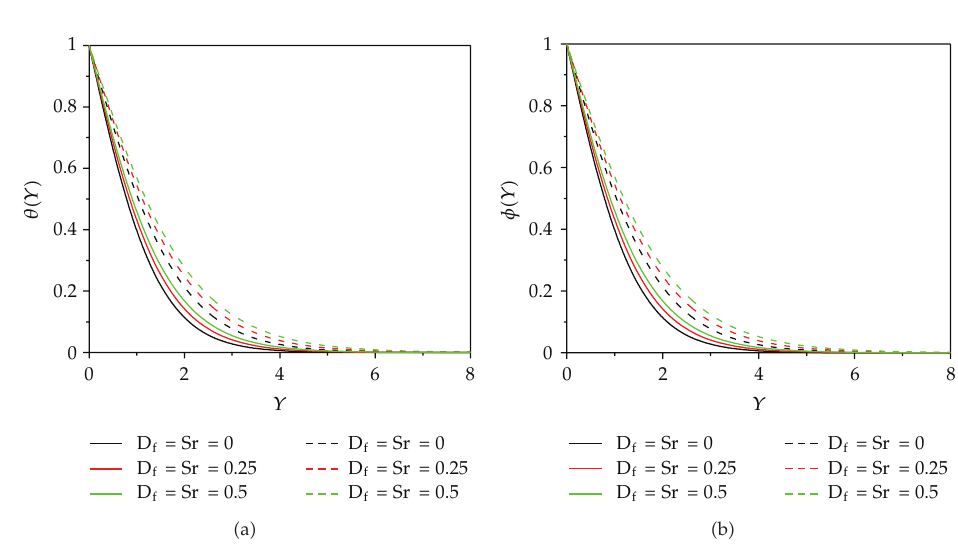
Figure 2: Cross-di ff usion e ff ect on (cid:3) a (cid:4) temperature and (cid:3) b (cid:4) concentration profiles with λ (cid:10) − 0 . 5 (cid:3) dashed lines (cid:4) and λ (cid:10) 0 . 5 (cid:3) solid lines (cid:4) .